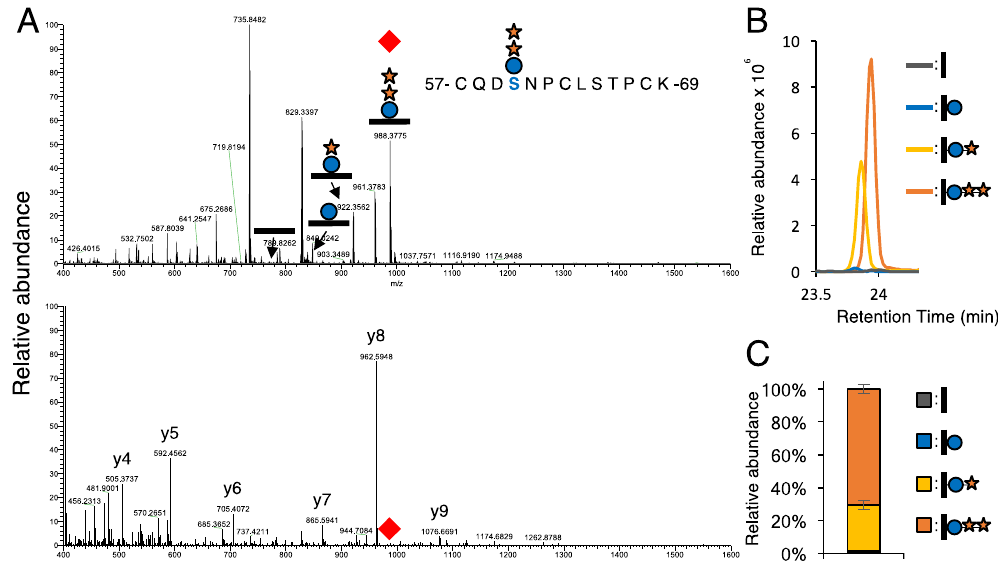
Figure 1. Identification of an O- glucosylated peptide from EGF2 from NOTCH1 by LC-MS/MS. NOTCH1 EGF1-18 protein was produced in the wild type HEK293T cells and purified from the culture medium, as described in the Materials and Methods. The protein was reduced, alkylated, and purified by SDS-PAGE, and subjected to in-gel trypsin digestion. The resulting peptides were analyzed by LC-MS/MS, as described in the Materials and Methods. ( A ) The top panel show an MS spectrum of 23.8 to 24.0 min. The bottom panel shows the MS/MS spectrum of the glycopeptide from EGF2 modified with a Xyl-Xyl-Glc trisaccharide. The red diamond denotes the parental ion. Numerous b- and y-ions confirmed the identity of the peptide 57-CQDSNPCLSTPCK-69 from NOTCH1. ( B ) Extracted ion chromatograms (EICs) searched for the glycopeptides modified with di ff erent glycoforms are shown. ( C ) Quantification was performed using the height of the EICs of the detected ions and the total amount of detected (glyco)peptides with di ff erent glycoforms set at 100% ( n = 3). Error bar shows standard error of the mean. Black bar—naked peptide; blue circle—glucose; orange star—xylose.